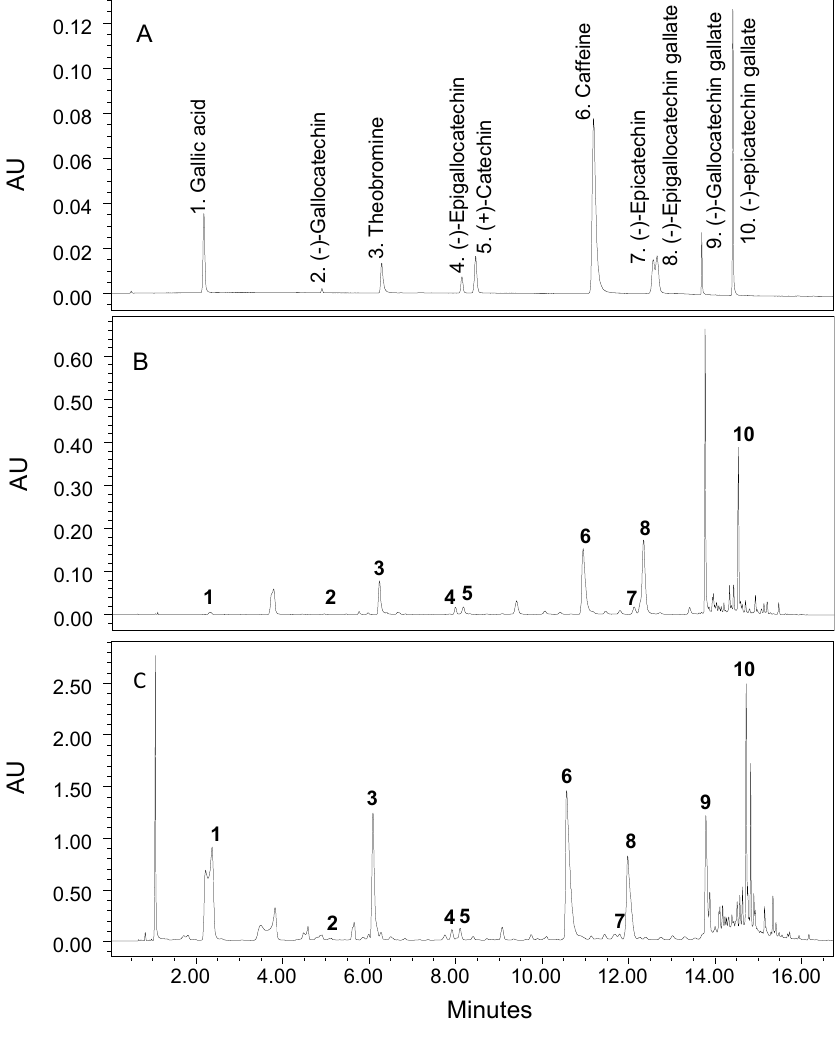
Figure 2. Typical UPLC chromatograms of a standard mix of authentic 7 catechin and other 3 bioactive compounds ( A ) and samples of purple tea leaves ( B ) and flakes ( C ).